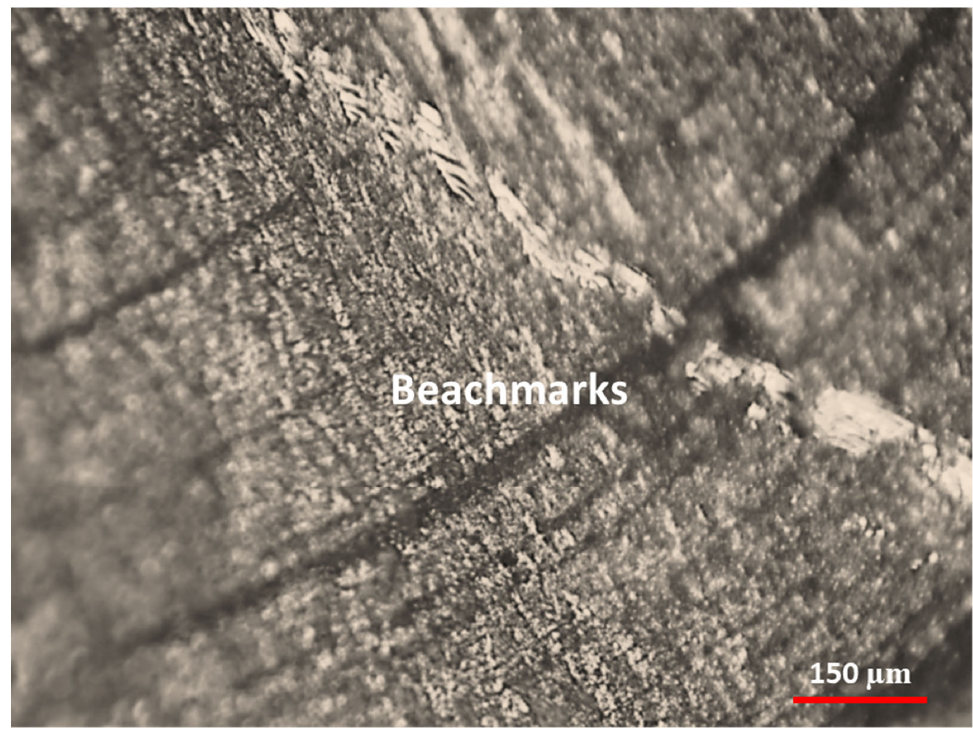
Figure 9. Beach marks on the fracture surface.